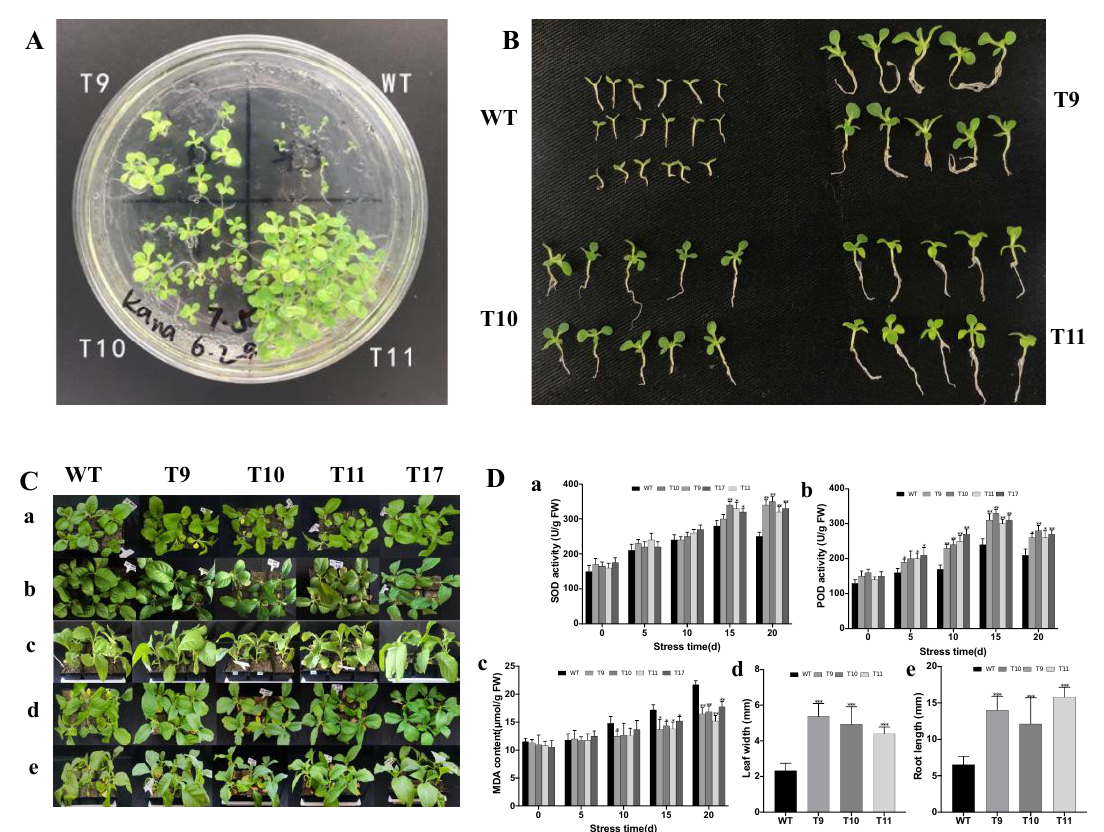
Figure 6. Comparison of the seed germination and growth between wild-type (WT) and transgenic (TG) plants under salinity stress. ( A ). Germination of WT and TG seeds on ½ MS medium containing 150 mM NaCl for 20 d. ( B ). Comparison of the WT and TG tobacco seedlings from ( A ) 20 d after salt stress. ( C ). Phenotypic characteristics of the TG and WT control plants under salt stress. (a): 0 d, top view; (b,c): 10 d after salt stress, top view and side view, respectively; (d,e): 20 d after salt stress, top view and side view, respectively. ( D ). Physiological parameters associated with plant stress response measured at various time points after salt treatment. (a) Effect of salt stress on plant SOD activity. (b) Effect of salt stress on plant POD activity. (c) Effect of the salt stress on plant MDA content. (d) Effect of salt stress on leaf width of the tobacco seedlings. (e) Effect of the salt stress on root length of the tobacco seedlings. Each column represents mean of three biological replicates. Error bars represent SE. A significant difference between WT and each TG line at p < 0.05, 0.01 or 0.001 by Student’s t - test was represented as “*”, “**” or “***”, respectively. Under salt stress, the growth of wild-type plants was significantly inhibited, the root length was significantly shorter than that of the transgenic plants, and the roots had no branches. Wild-type controls had only two true leaves, whereas the transgenic plants had four true leaves. The wild-type leaves were yellow, whereas the leaves in transgenic plants were green and significantly larger than the wild-type controls